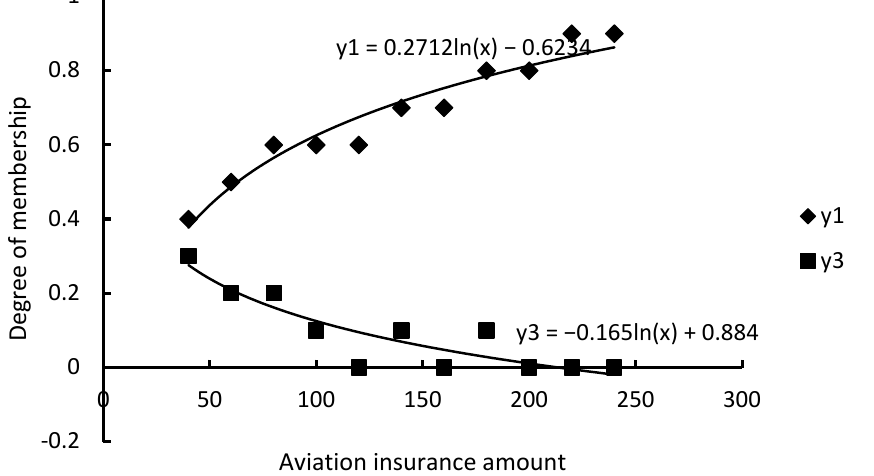
Figure A30. Single factor evaluation for the index of aviation insurance amount (40 ten thousand yuan and above). y1 = −0.5407x + 0.8187